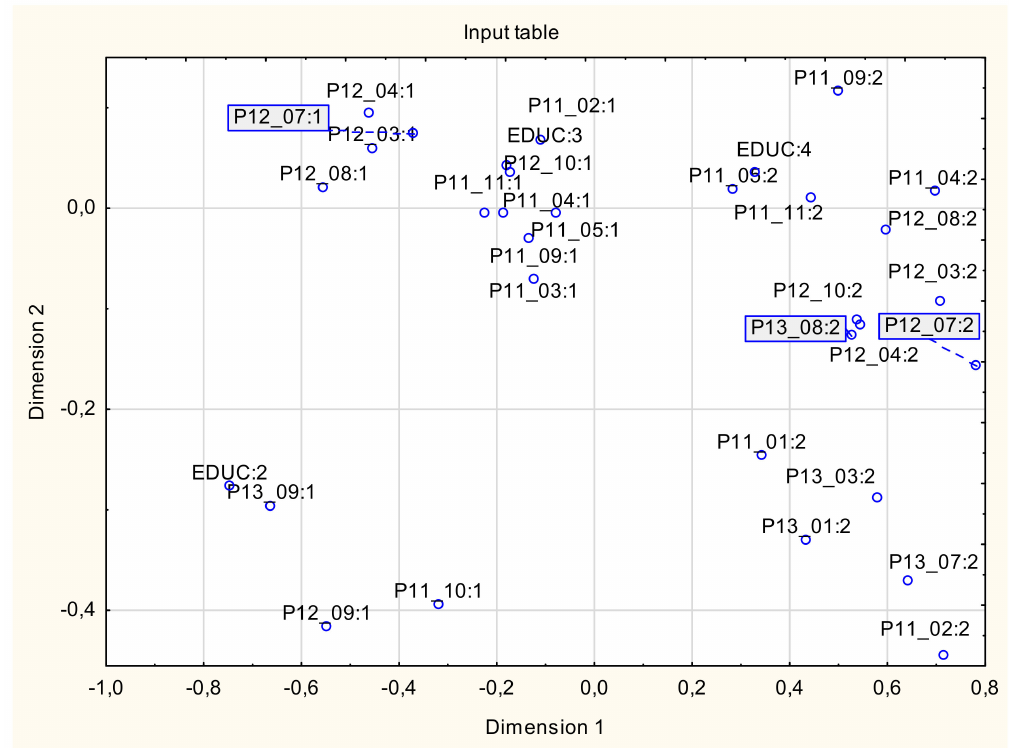
Figure 3. Two-dimensional map of perception for the education variables and subjective evaluation of the components of